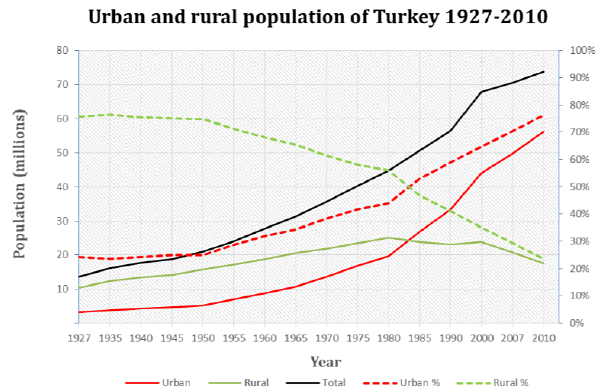
Figure 12. Population distribution of Turkey in rural vs. urban areas between 1927 and 2010 and rural vs. urban percentage in total pop- ulation for each survey year. The time interval between survey years varies before 1935 and after 1990 (Turkish Statistical Institute).